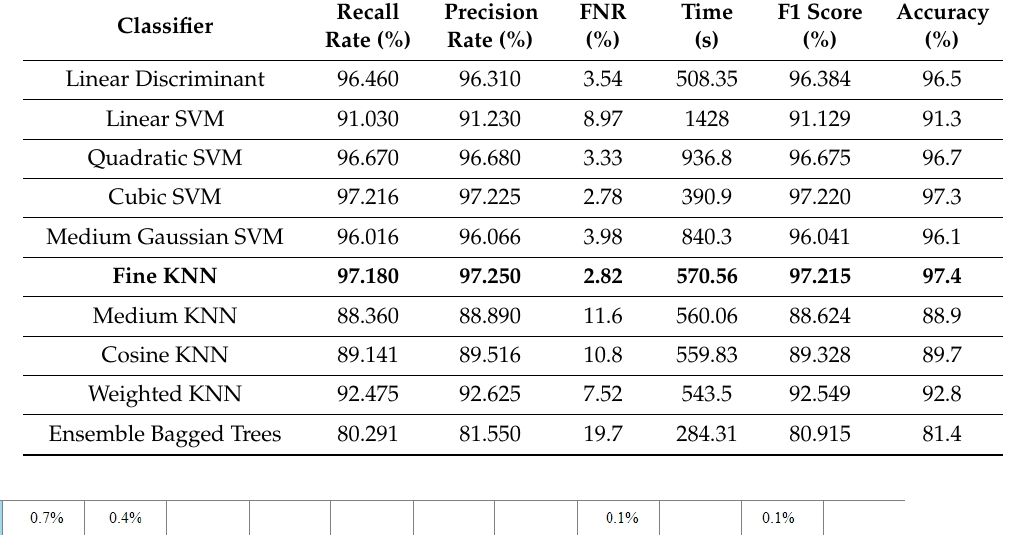
Table 6. Achieved results on IXMAS dataset after fusion of deep features using SbE approach. The bold represents the best obtained values.